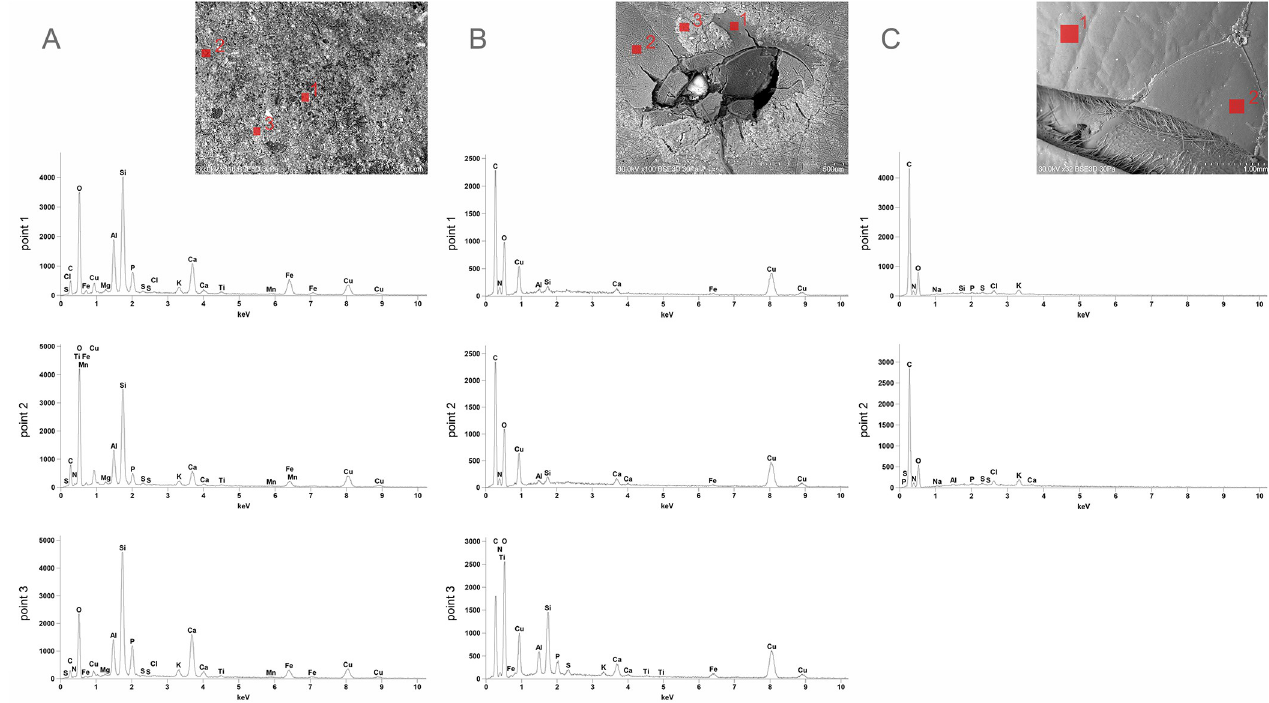
Fig 7. The results of the SEM-EDS elemental composition tests of two samples from Geotrupes stercorarius beetle coming from the urn from burial 506 (samples A and B) and the reference sample of a modern insect. Sample A consists of right elytron covered with sediment, sample B consists of left elytron with cleaned off sediment, and sample C represents the modern insect.